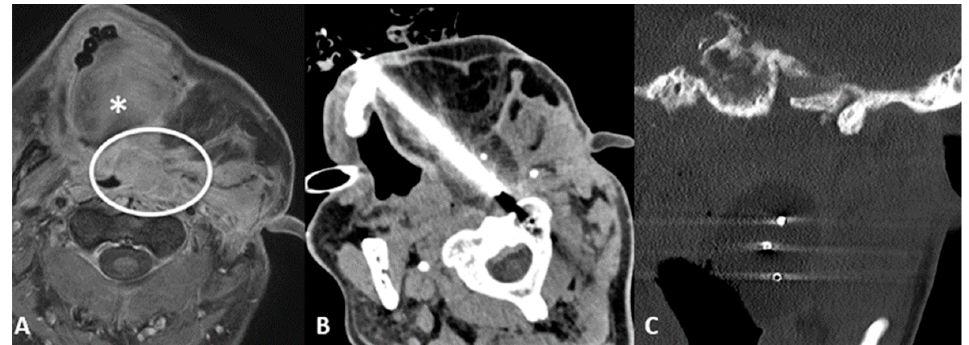
Figure 4. 70-year-old male with airway impairment and left postauricular discharge. Previous nasopharyngeal carcinoma and radiation-induced squamous cell carcinoma of maxilla which underwent maxillectomy, mandibulectomy, parotidectomy, and myocutaneous flap reconstruction. ( A ) T1-weighted postcontrast axial MRI scan showing extensive tumor recurrence (white circle), posterior to the tongue (*), threatening the airways and invading the left external auditory canal. ( B ) Axial CT scan showing cryoablation needle placement through the myocutaneous flap. ( C ) Coronal-oblique multiplanar reconstruction CT scan showing the ice ball formed by the three cryoprobes.